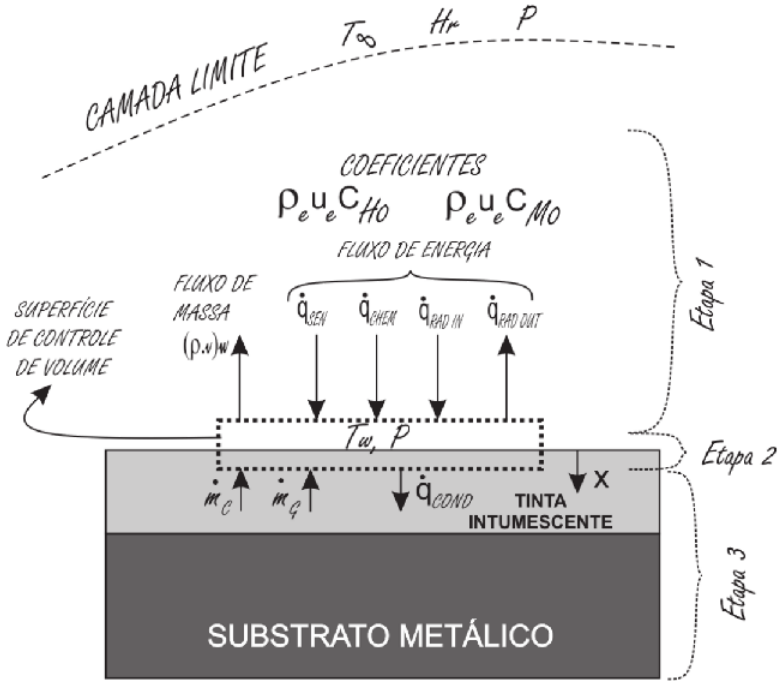
Scheme of the procedure adopted to predict the electrochemical behavior of coating (Source: Adapted of Clark et al